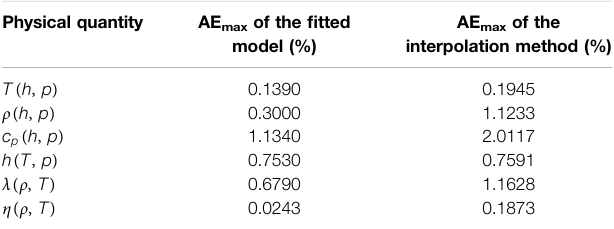
AE max of the model (%) interpolation method (%)